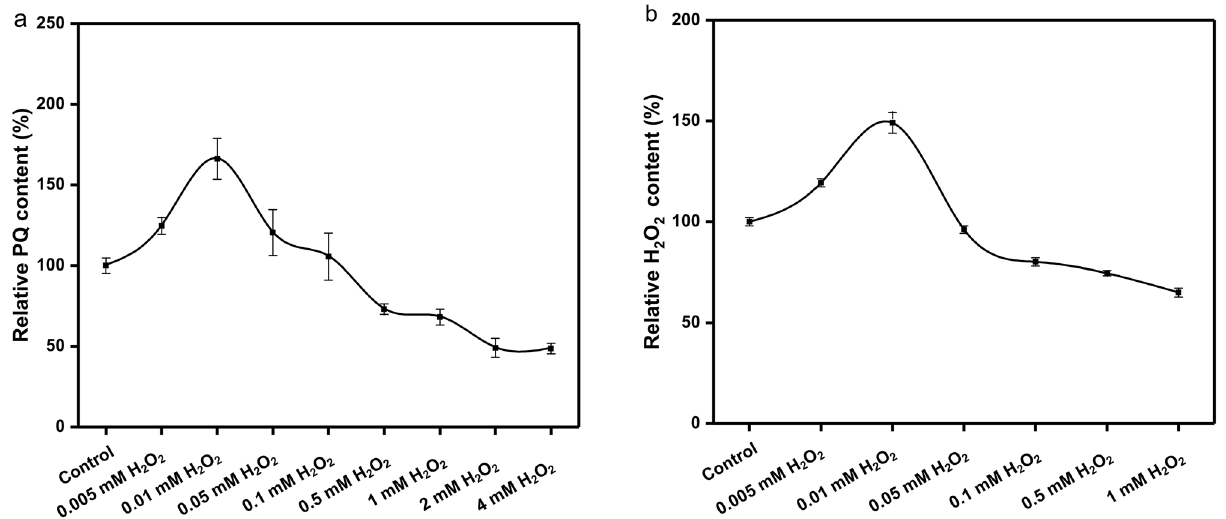
Figure 1. Effects of different concentrations of H 2 O 2 on perylenequinones production and intracellular H 2 O 2 . Values are the means of five independent experiments ±